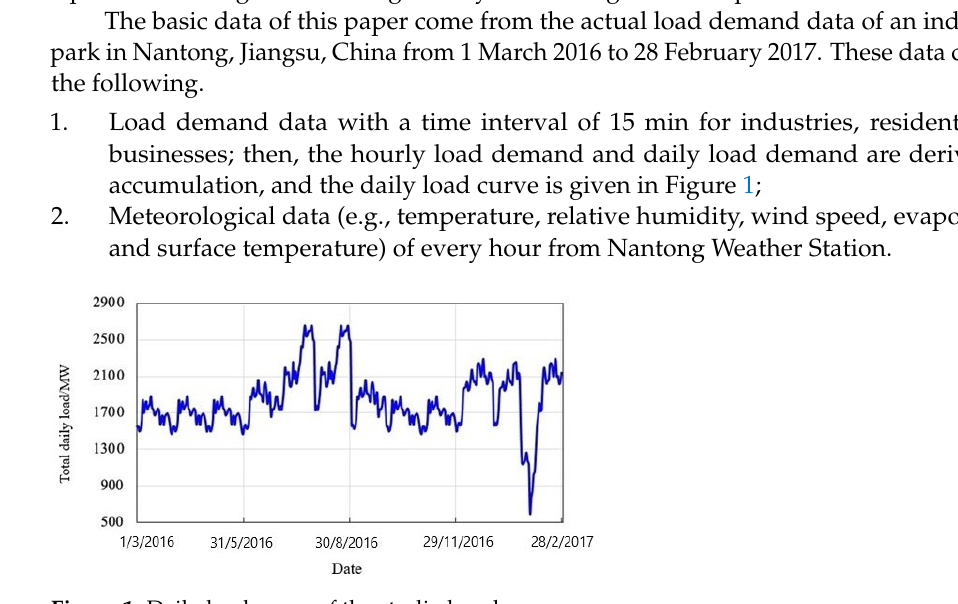
Figure 1. Daily load curve of the studied